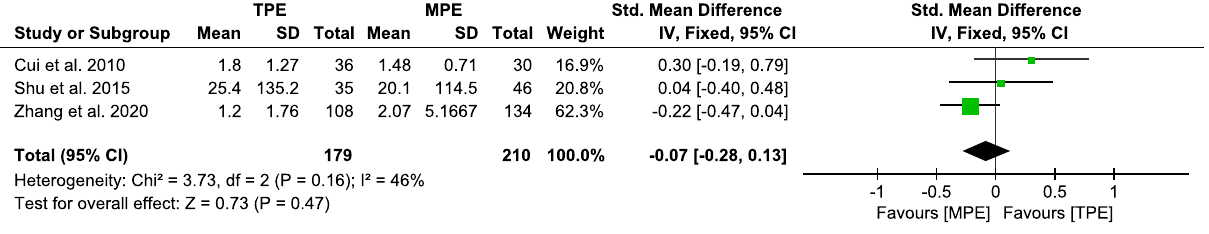
Figure 4. Forest plot of 3 studies comparing IL-2 levels in TPE and MPE subjects. The standardized mean difference (the pleural effusion levels of IL-2 in TPE subjects minus that in MPE subjects) was estimated by meta-analysis.